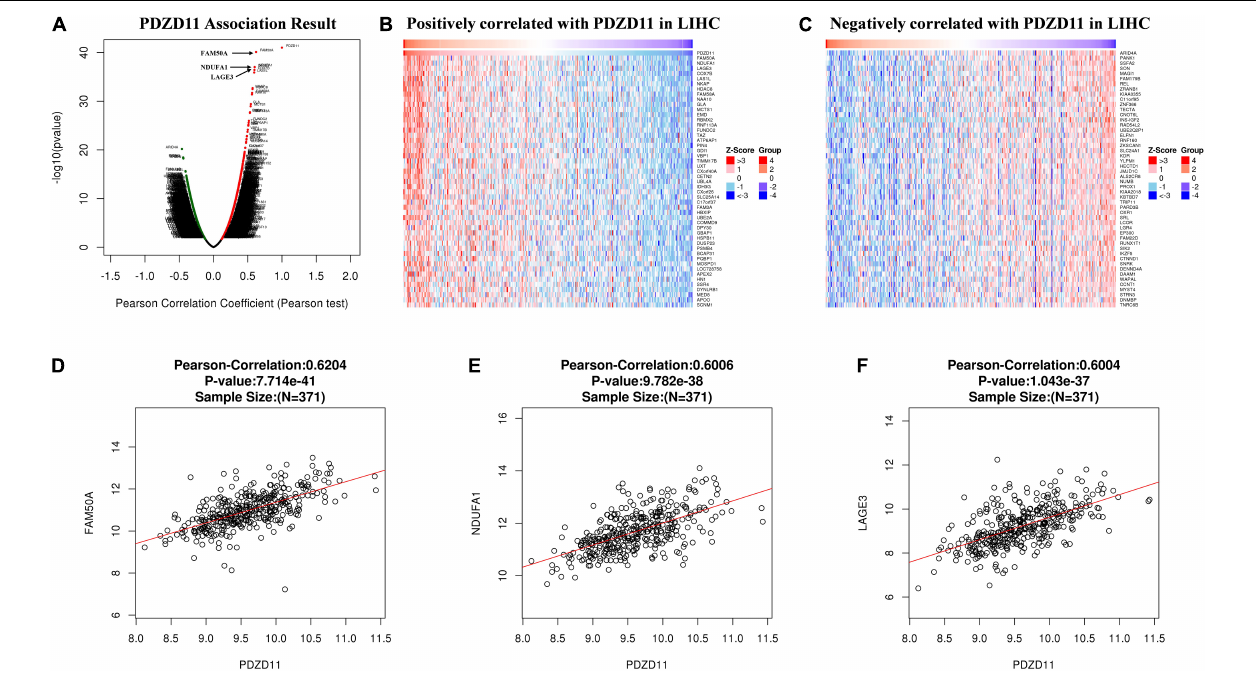
FIGURE 5 | Differentially expressed genes that correlated with PDZD11 in LIHC (LinkedOmics database). (A) A Pearson test was used to determine the correlations between PDZD11 and differently expressed genes in LIHC. (B,C) Heat maps are showing genes (Top 50) positively or negatively correlated with PDZD11 in LIHC. Red indicates positively correlated genes and blue indicates negatively correlated genes. (D–F) The scatter plots mean that PDZD11 expression is positively correlated with the expression of FAM50A (D) , NDUFA1 (E) , and LAGE3 (F)